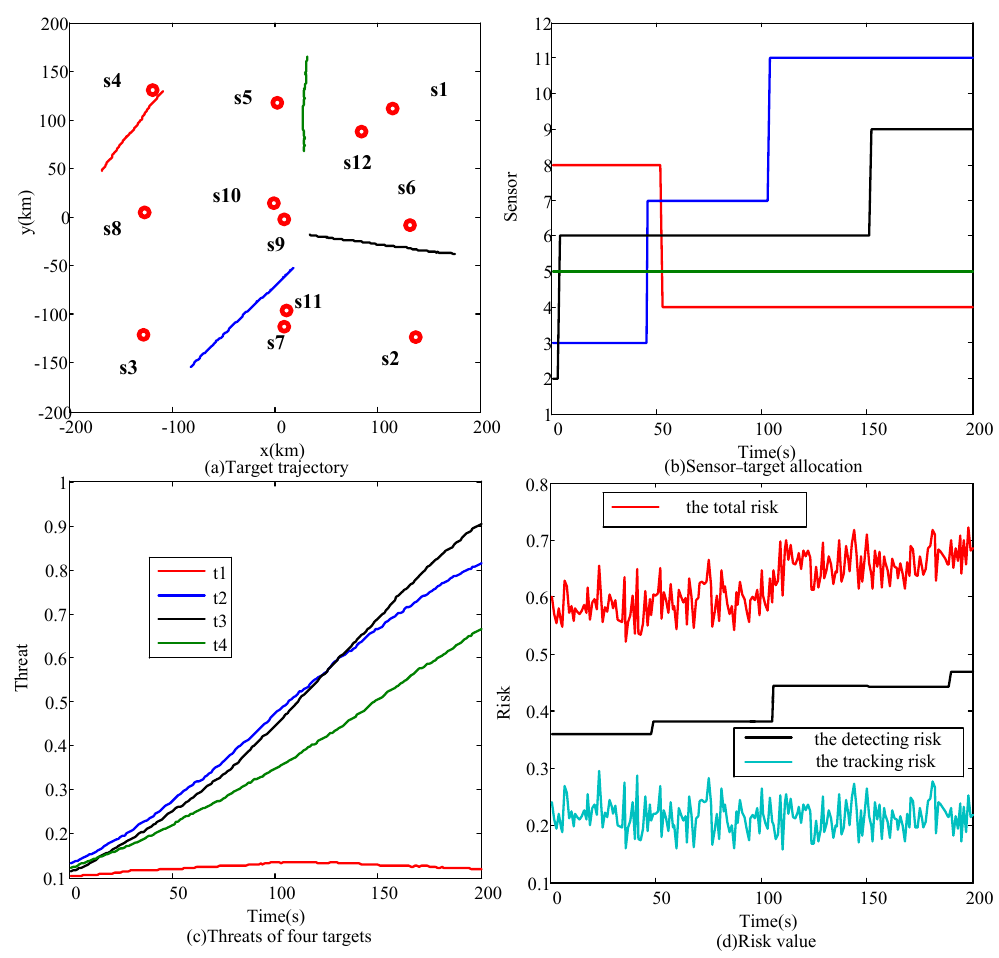
Figure 10. Sensor scheduling process.